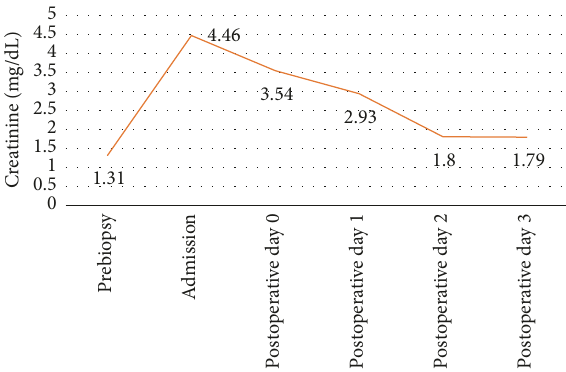
Figure 2: Creatinine trend in perioperative